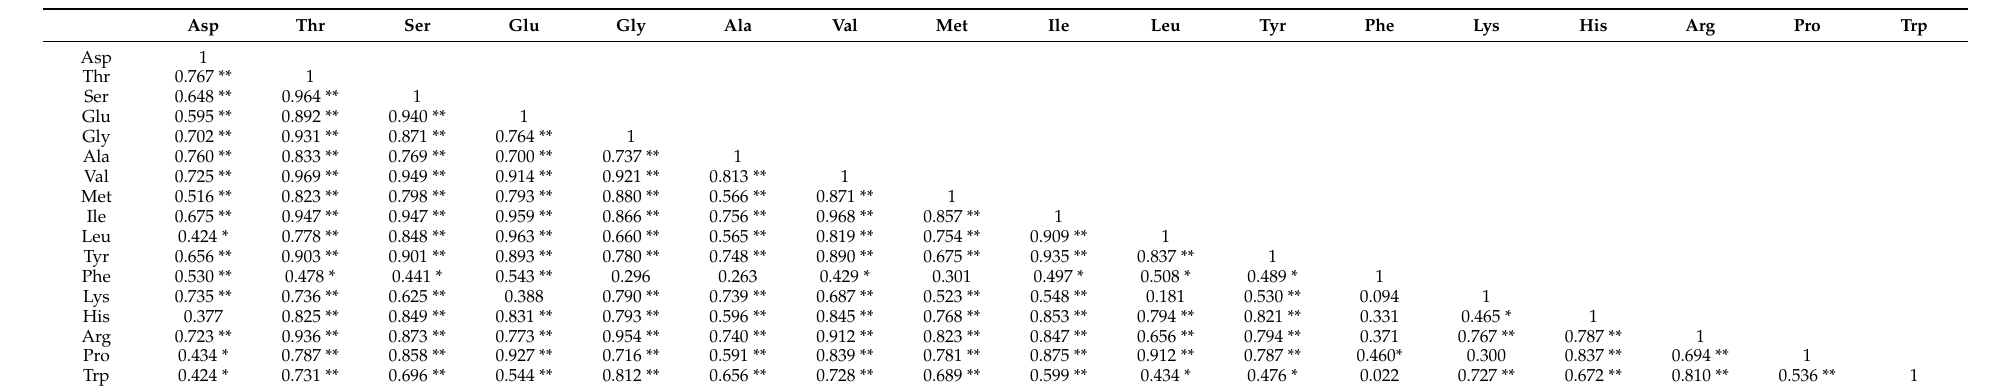
Table 16. The correlation matrix between different amino